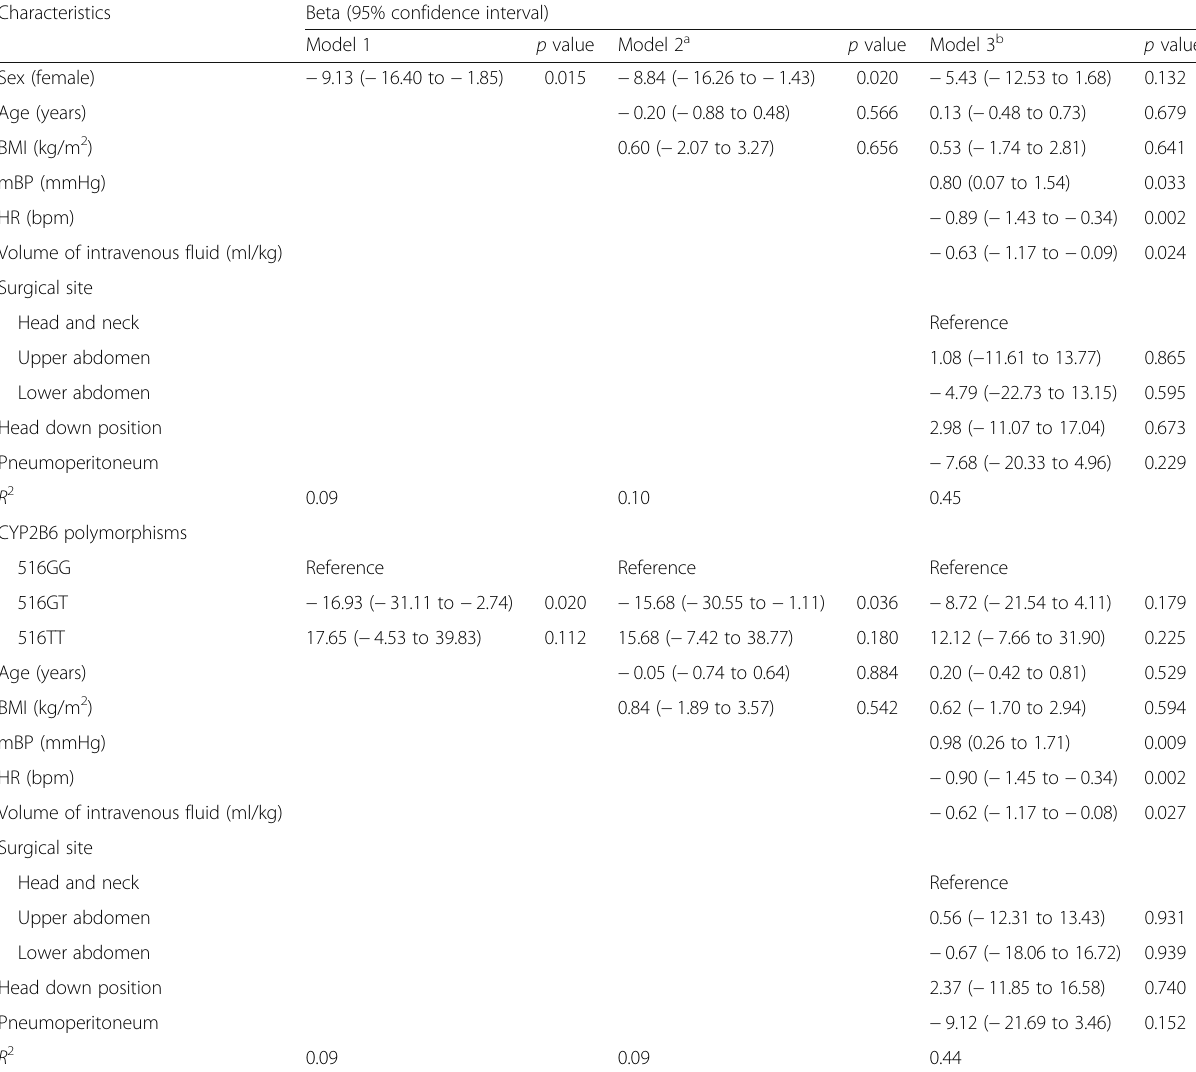
Table 3 Regression coefficients of sex and CYP2B6 516G > T polymorphisms for performance errors estimated with linear regression, adjusted for background characteristics and clinical factors